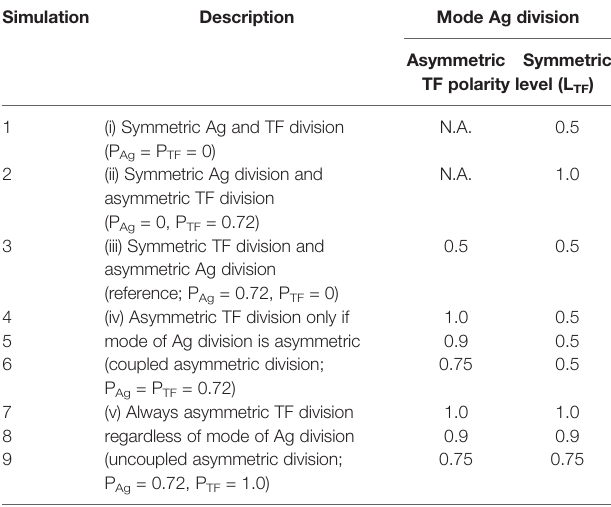
TABLE 2 | Simulated asymmetry of TF concentrations (polarity level L TF ) in daughter cells after division. Simulation